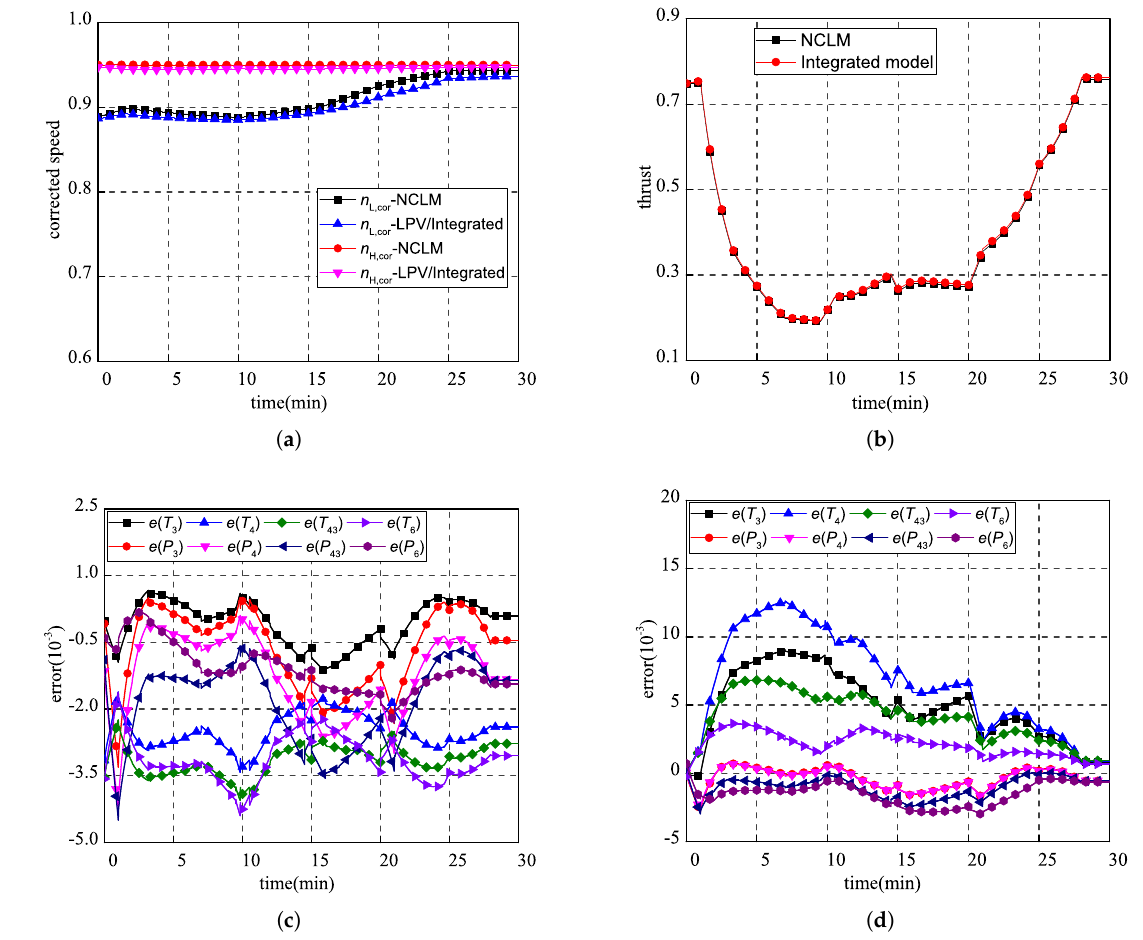
Figure 9. Comparison between the nonlinear component level model (NCLM) and the integrated model: ( a ) Comparison of state, ( b ) comparison of thrust, ( c ) output error of the integrated model, and ( d ) output error of the traditional linear parameter varying (LPV) model.